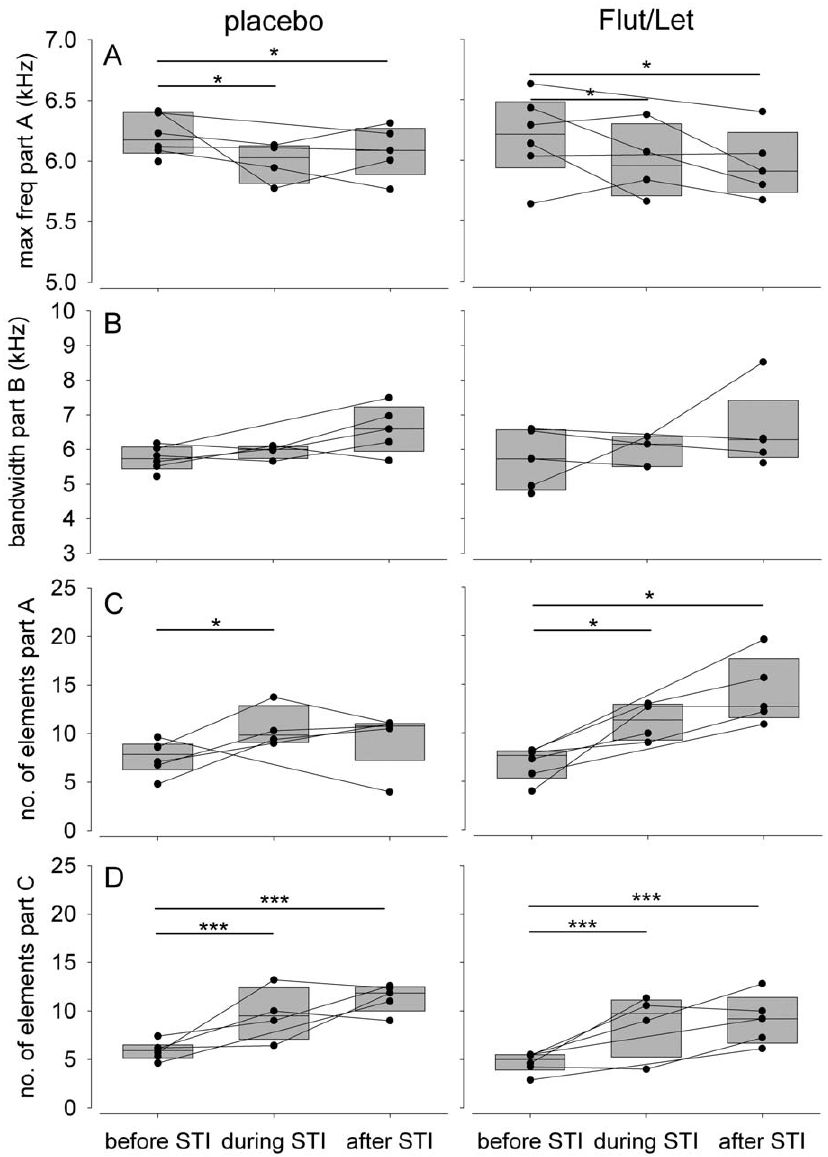
Figure 4. Structural song measures before, during and after the STI. Depicted separately for males treated with flutamide and letrozole (‘Flut/Let’, n=6) and placebo treated males (‘placebo’, n=6) in fall. Each circle represents one individual male and measurements of the same male are connected by a line. Asterisks indicate significance (* p , 0.05, *** p , 0.001) and are according to a priori set contrasts (before vs. STI and before vs. after the